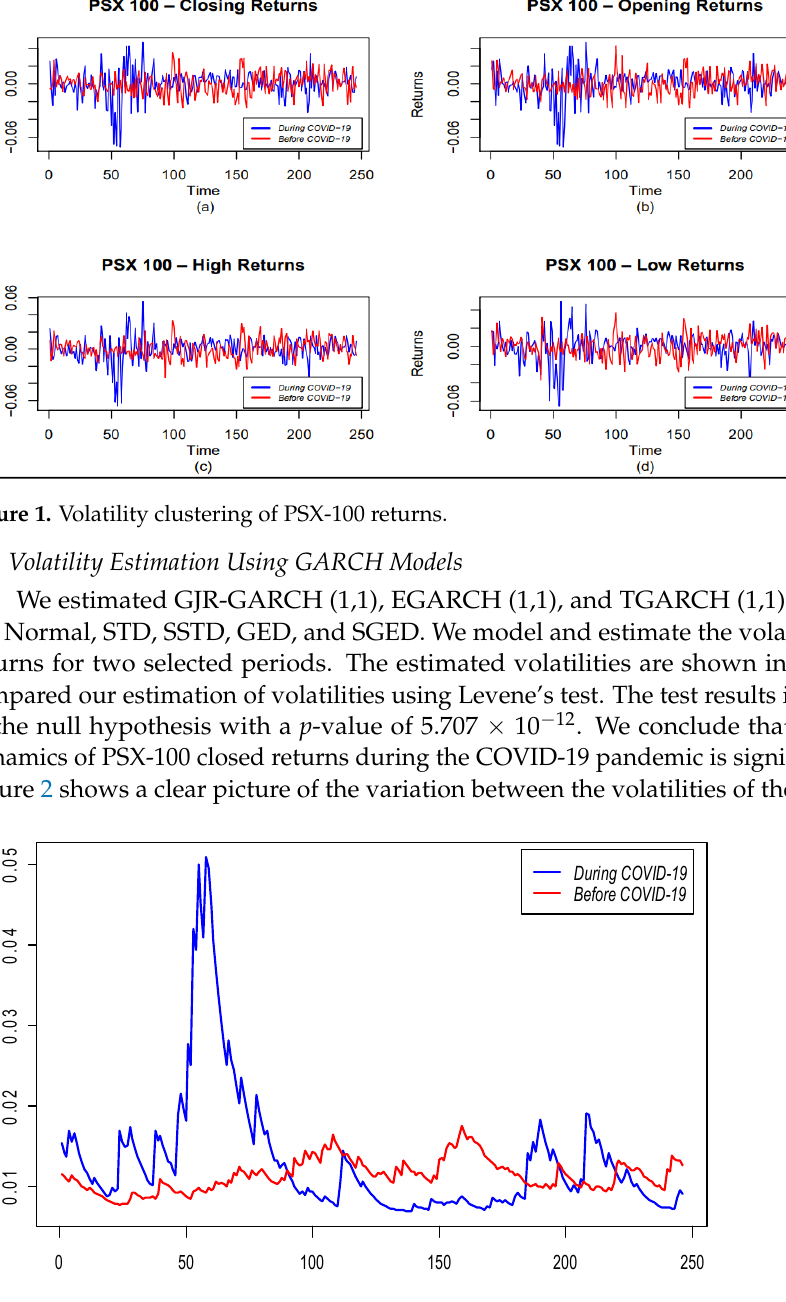
Figure 1. Volatility clustering of PSX-100 returns.